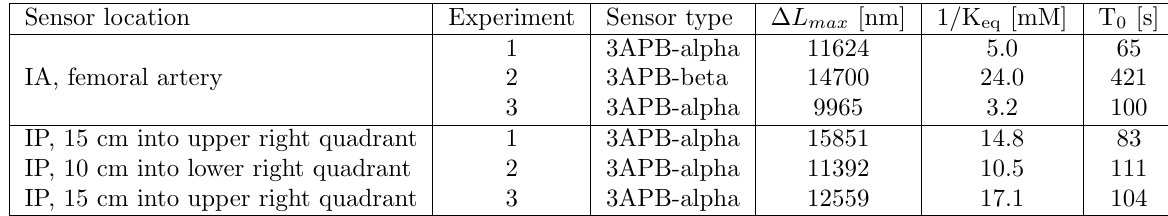
Table 2: Sensor types and parameter